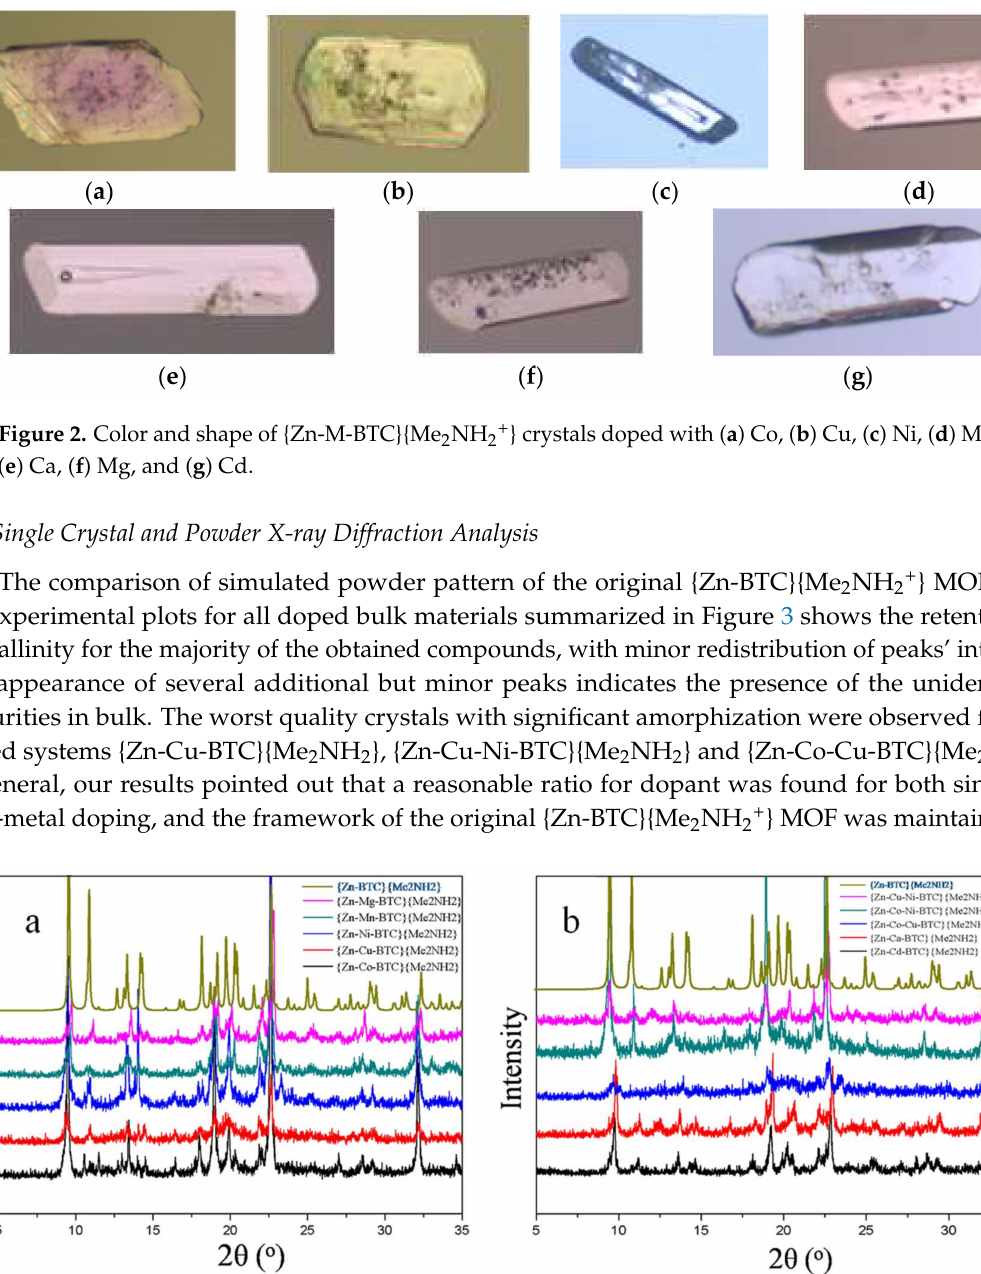
Figure 3. Powder pattern comparison of metal doped system and {Zn-BTC}{Me 2 NH 2+ } simulated pattern obtained from single crystal X-ray data (marsh line) for single-metal doped ( a ) and dual-metal doped ( b )